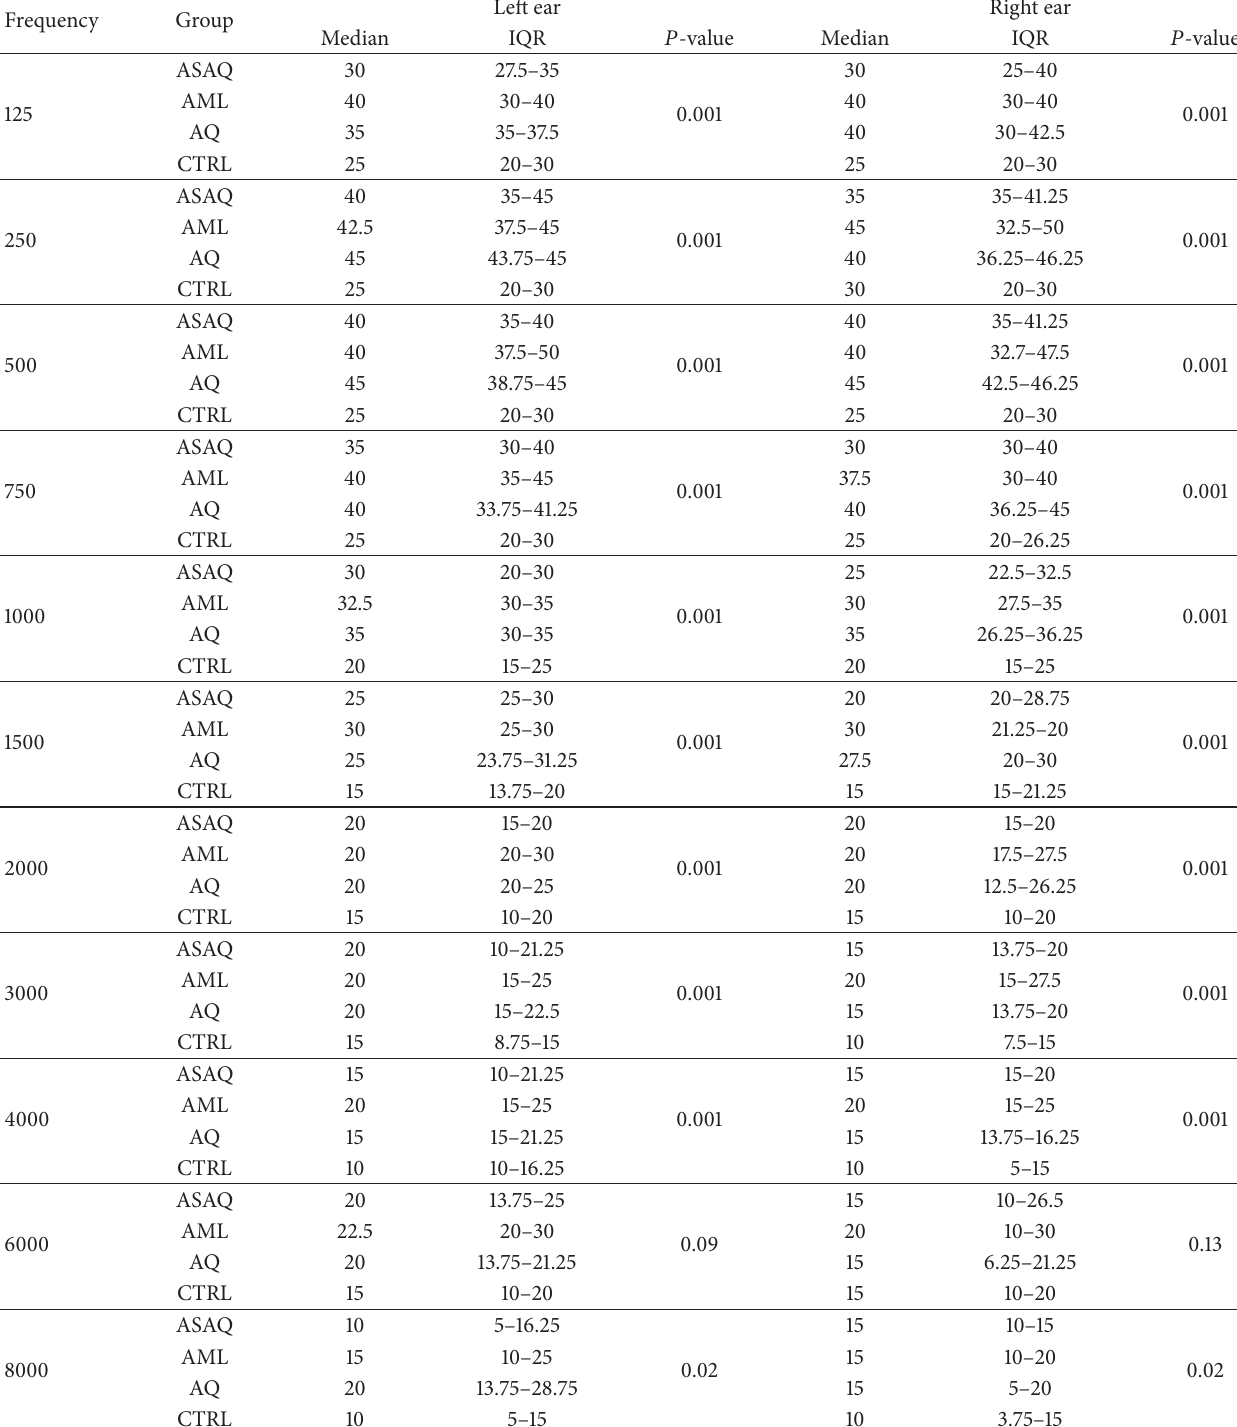
Table 1: Median hearing threshold levels on day 0 (before